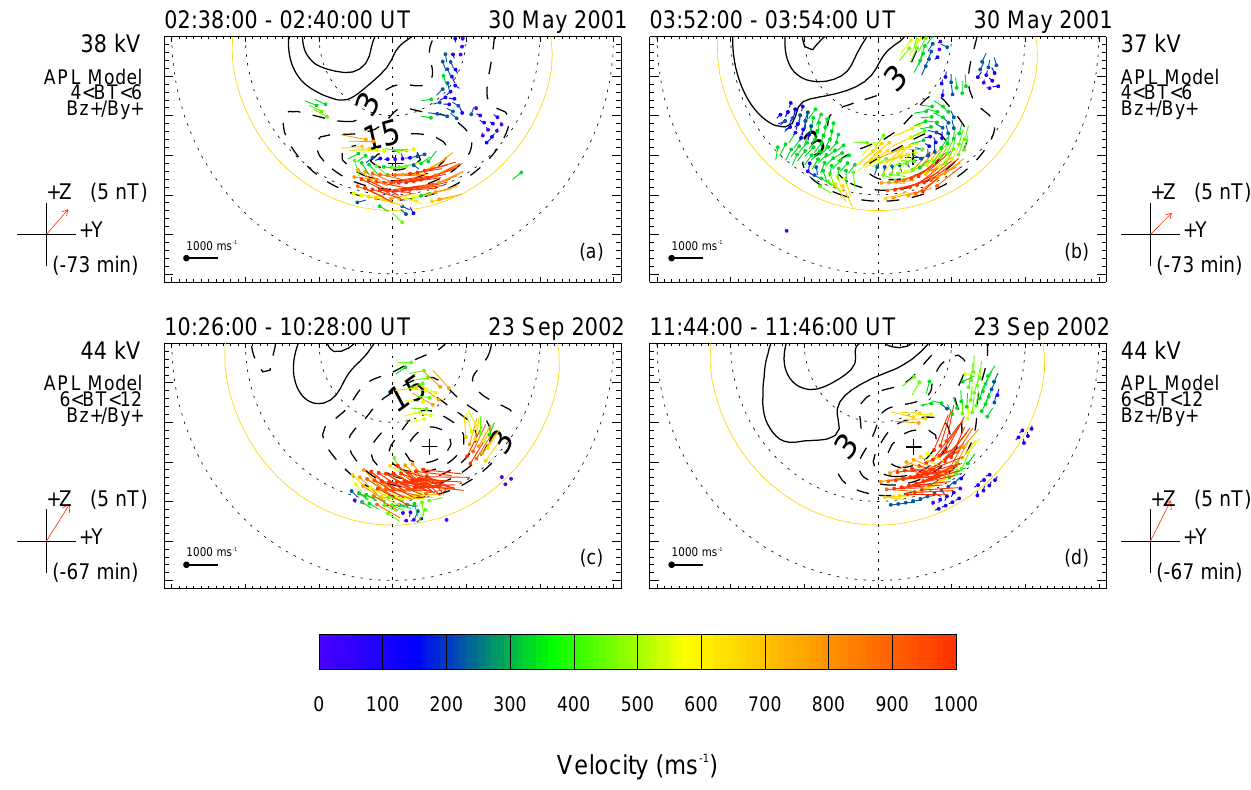
Fig. 6. Flow maps illustrating the flow “bursts” from two additional intervals are shown in the same format as Fig.